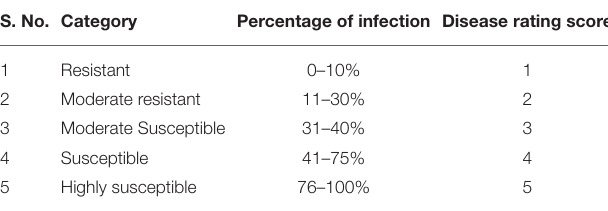
TABLE 1 | Disease rating scale of urdbean leaf crinkle virus. S. No.